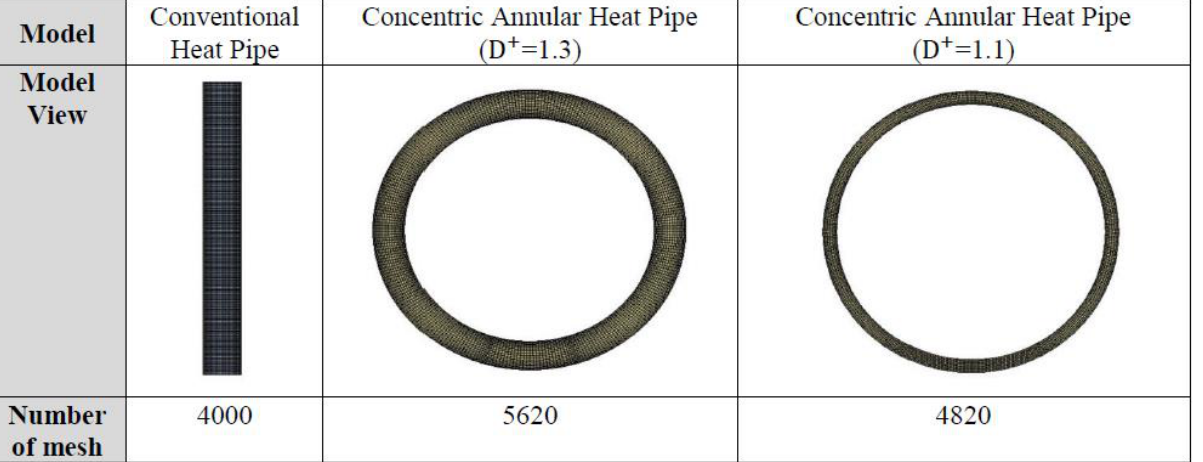
Energies 2021 , 14 , 3333